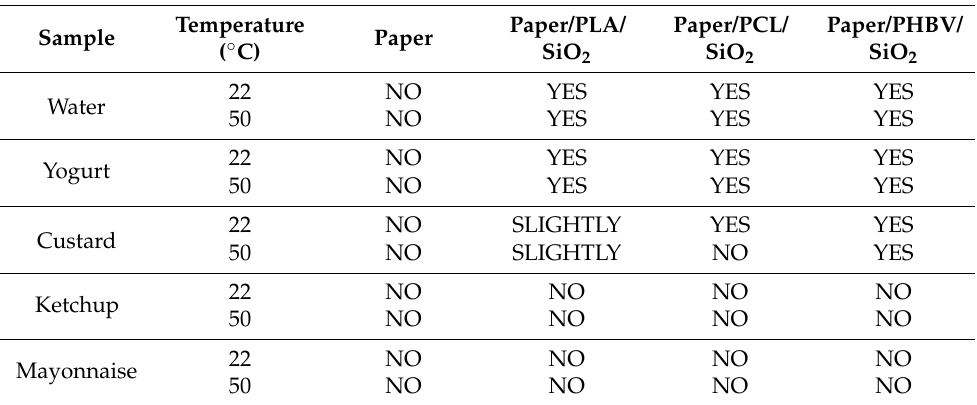
Roll-off capacity at 45 ◦ angle of the uncoated paper and the multilayer struc- tures based on paper, electrospun polylactide (PLA), poly( ε -caprolactone) (PCL), and poly(3- hydroxybutyrate-co-3-hydroxy-valerate) (PHBV) mats, and electrosprayed hydrophobic silica microparticles Paper/PLA/SiO 2 annealed at 160 ◦ C, Paper/PCL/SiO 2 annealed at 55 ◦ C, and Paper/PHBV/SiO 2 annealed at 120 ◦ C using water, yogurt, custard, ketchup, and mayonnaise at 22 and 50 ◦